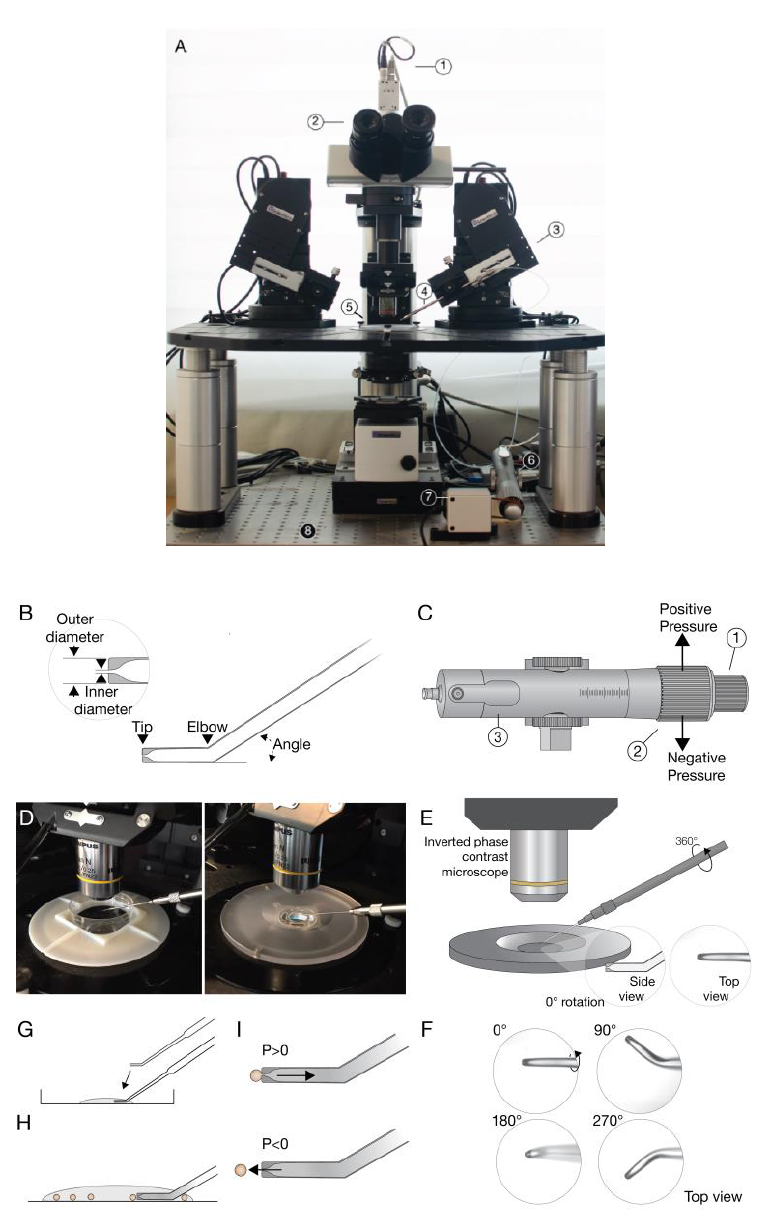
Figure 1. System construction and operation. ( A ) 1. Camera; 2. inverse phase contrast microscope; 3. micromanipulator; 4. microinjection holder; 5. microscope stage; 6. microinjector; 7. microinjector engine; 8. vibration isolated platform. ( B ) Holding micropipette with a flat, polished opening. Two sizes were used: a small holding micropipette (SHM) and a baby holding micropipette (BHM). The SHM has an outer diameter of 65–95 µ m, and an inner diameter of 15–20 µ m, and an angle of 35 ◦ . SHM is suitable for patterning of particles of 30 µ m diameter. The BHM has an outer diameter of 35 µ m and an inner diameter of 5–7 µ m, and an angle of 30 ◦ . BHM is suitable for patterning of particles smaller than 20 µ m diameter. ( C ) Microinjector:1. Pressure relief valve; 2. coarse knob; 3. fine knob ( D ) Working plate: 25 mm petri-dish placed on working plate (left). Custom CAD design of cell-holding device embedded on working plate for separation between di ff erent types of particles. Has a central well for assembly and four external wells, signed with letters for particle reservoirs (right). ( E ) Pipette approach to particle. The microinjector holder can be rotated in 360 ◦ to give di ff erent angle approaches of the micropipette. The pipette approach is monitored by the microscope that gives a top view of the pipette. The default approach (0 ◦ ) is when the bent part of the pipette is parallel to the surface ( E ). A rotation of 90° (/ − 90°) is used for patterning, enables correct manipulation and monitoring of the process (F) . (G) A drop of the particle solution is loaded onto the